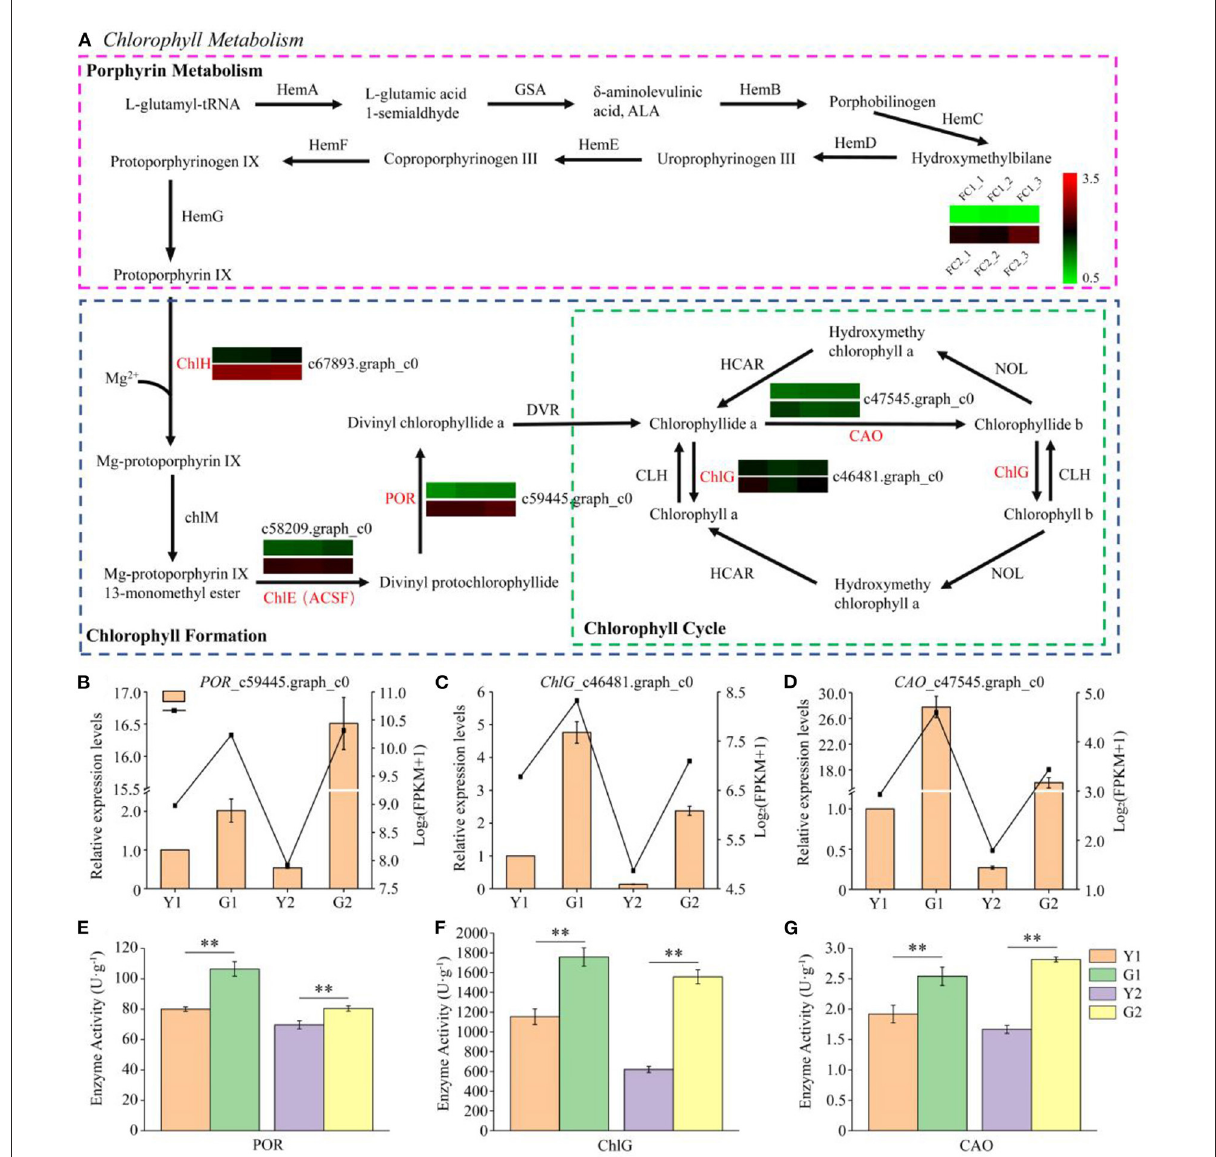
FIGURE5 Transcriptional profiling of DEGs involved in porphyrin and chlorophyll metabolism. (A) DEGs involved in porphyrin and chlorophyll metabolism. HemA glutamyl tRNA reductase, GSA glutamate 1-semialdehyde aminotransferase, HemB porphobilinogen synthase, HemC hydroxymethylbilane synthase, HemD uroporphyrinogen III synthase, HemE uroporphyrinogen III decarboxylase, HemF coproporphyrinogen oxidative decarboxylase, HemG protoporphyrinogen synthase, ChlH magnesium chelatase H subunit, ChlM magnesium-protoporphyrin IX methyltransferase, ChlE (ACSF) magnesium-protoporphyrin IX monomethyl ester (oxidative) cyclase, POR protochlorophyllide reductase, DVR 3,8-divinyl chlorophyllide a 8-vinyl reductase, CAO chlorophyllide a oxygenase, ChlG chlorophyll synthase. (B–D) Relative expression of three selected genes validated by qPCR. (E–G) Determination of POR, ChlG and CAO enzyme activities. Data is presented as the mean ± standard deviation. Statistical analyses were performed by student’s t -test. ** p <